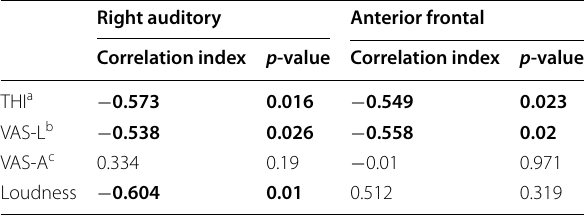
Table 4 The results of the correlation between the changes of subjective evaluations and the changes of ASSR 40-Hz amplitude in two regions of